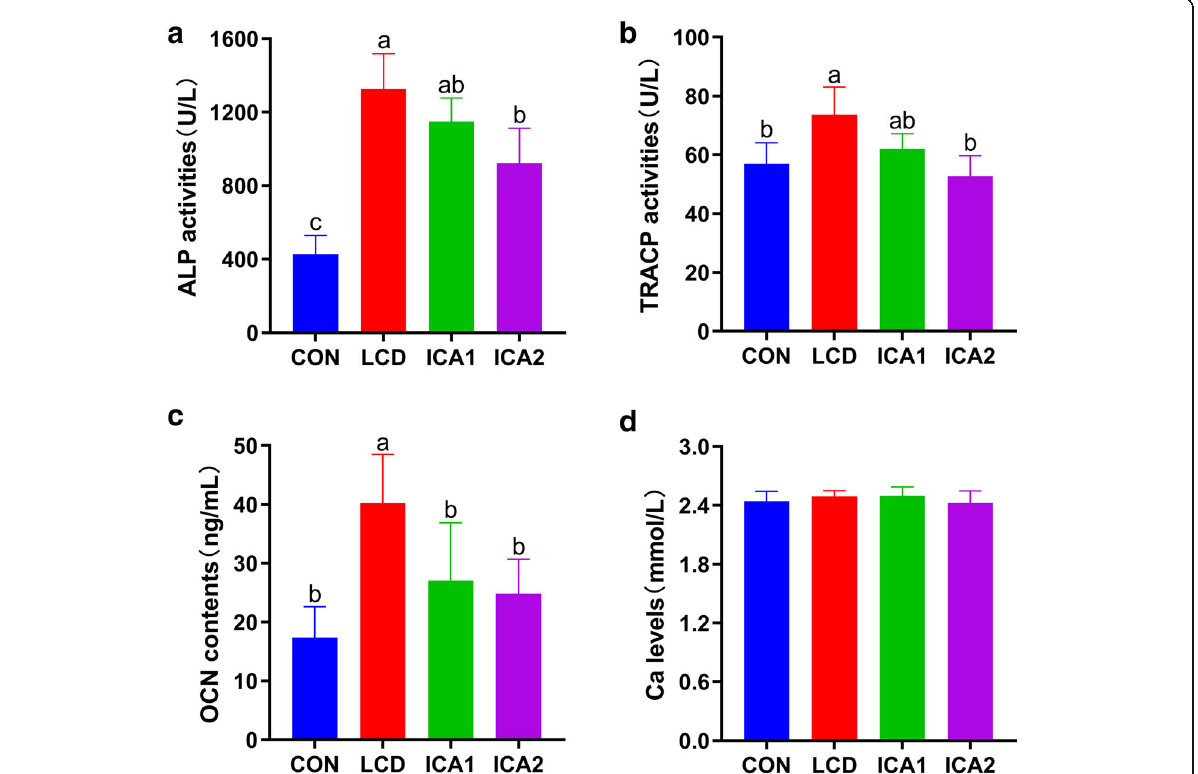
Fig. 3 Effects of ICA supplementation on serum bone metabolism index. a Activities of ALP. b Contents of OCN. c Activities of TRACP. d Levels of serum Ca. ALP, alkaline phosphatase. OCN, osteocalcin. TRACP, tartrate resistant acid phosphatase. ICA, icariin. CON, basal diet. LCD, low calcium diet. ICA1, low calcium diet supplied with 0.5 g/kg ICA. ICA2, low calcium diet supplied with 2.0 g/kg ICA. Data are presented as the mean ± SD ( n = 6). Means in each column with different alphabetic letters are significantly ( P < 0.05)